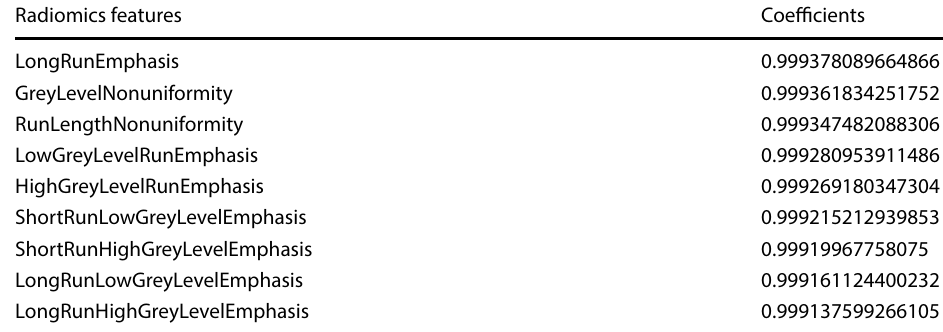
Table 3 ICC coefficients for all radiomics